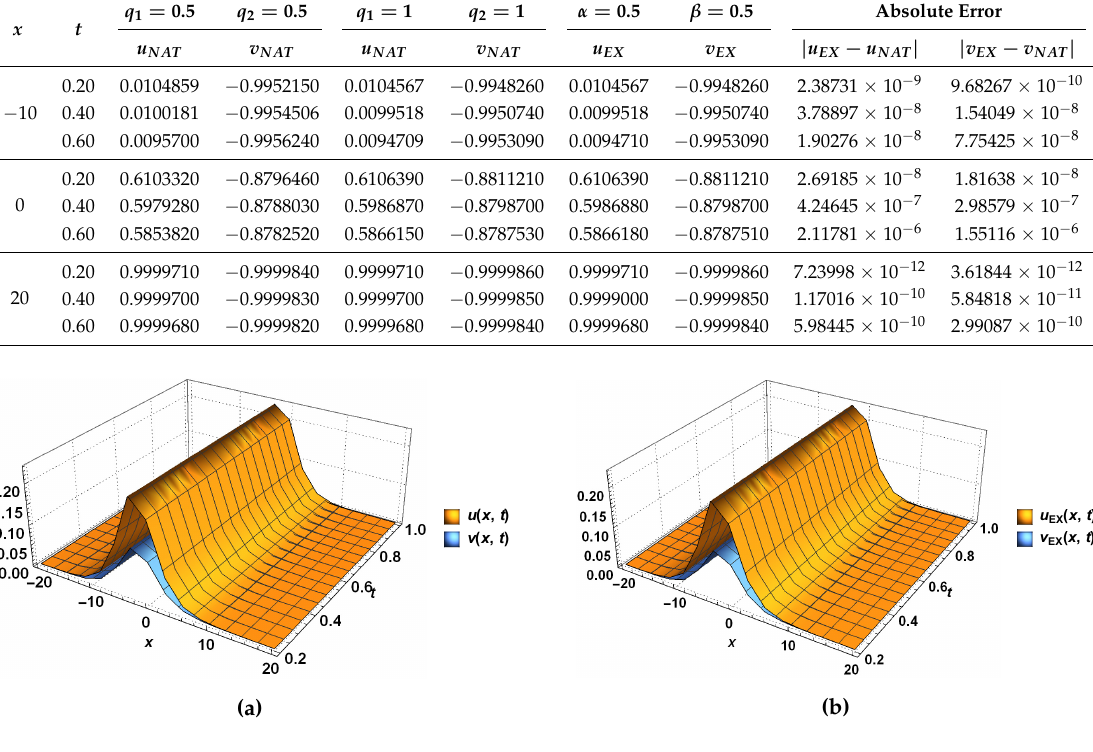
Figure 2. ( a ) The graph for the approximate solution of Example 1 for α = β = 0.5, γ = 1 and q = 1; ( b ) The graph for the exact solution of Example 1 for α = β = 0.5 and γ =